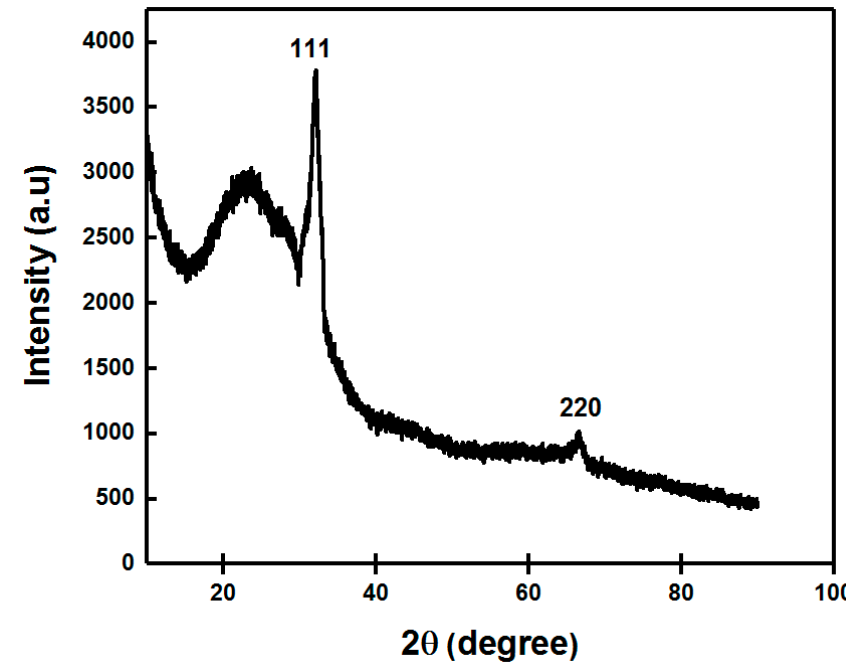
Figure 6. X-ray diffraction (XRD) pattern of green synthesized AgNPs.